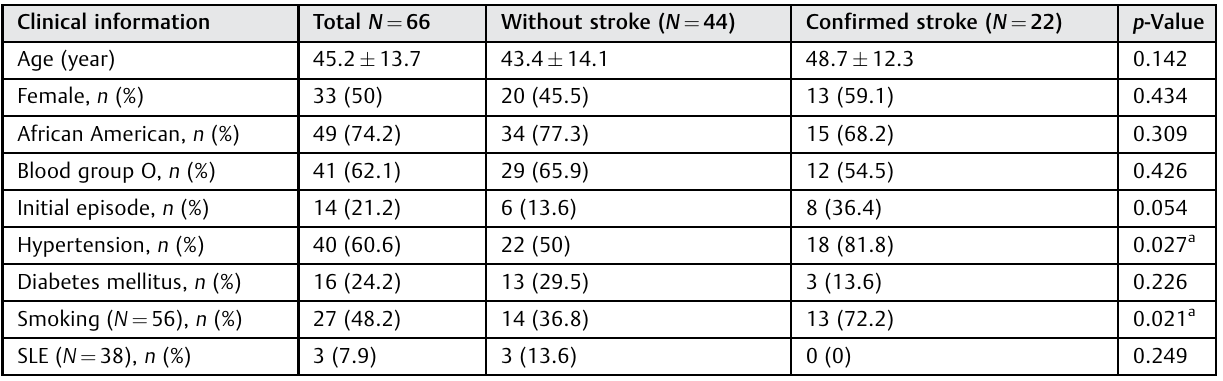
Table 1 Clinical characteristics in all iTTP patients with or without an imaging-con fi rmed ischemic stroke Clinical